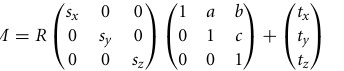
FIGURE 2 |Average and standard deviation of the percentage of motion-corrupted gradient directions as a function of thresholding on the estimated rotation angle in degrees (left) and the estimated